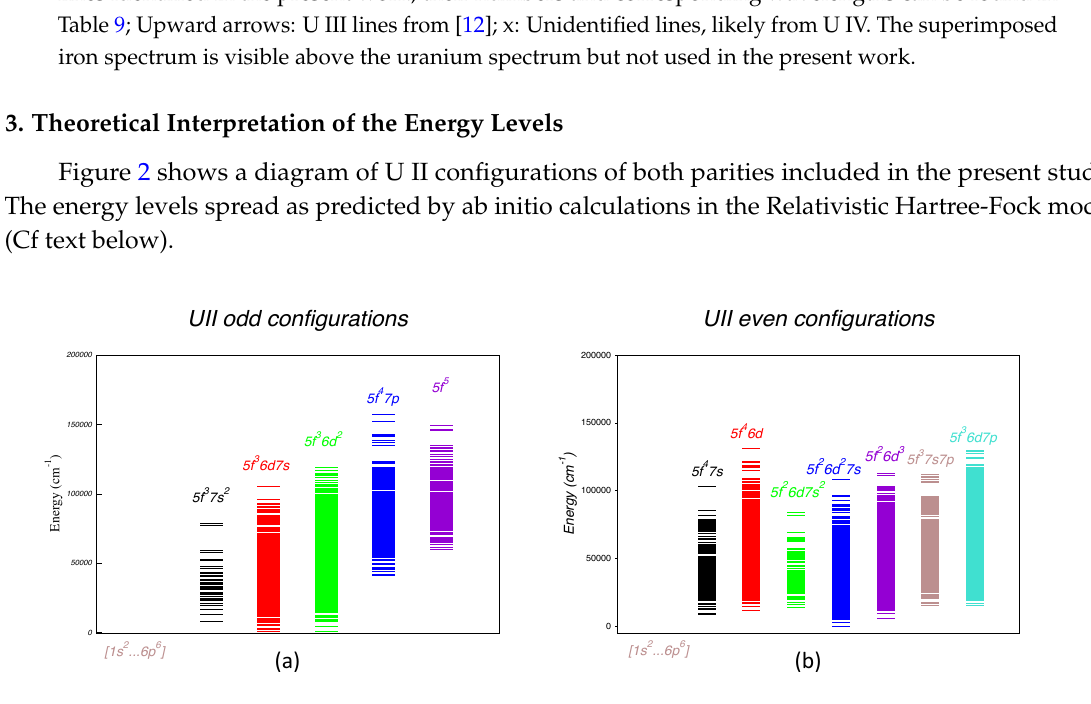
Figure 2. Energy levels of U II belonging to the configurations included in the present study as predicted by ab initio HFR calculations. ( a ) Odd parity configurations. ( b ) Even parity